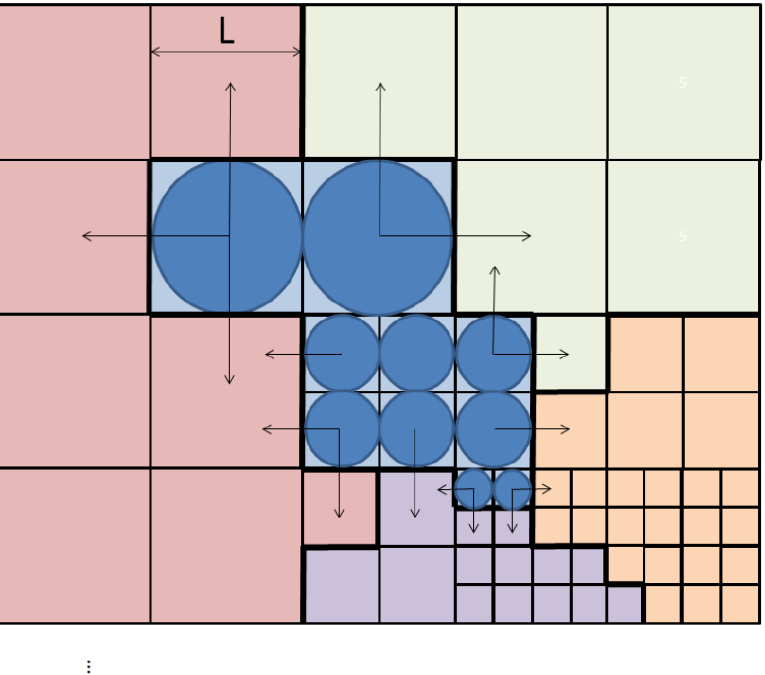
Figure 12. The region on a foveal image could be composed of rexels of different sizes. This will influence the computation of perimeters, means or moments (see the text for details).